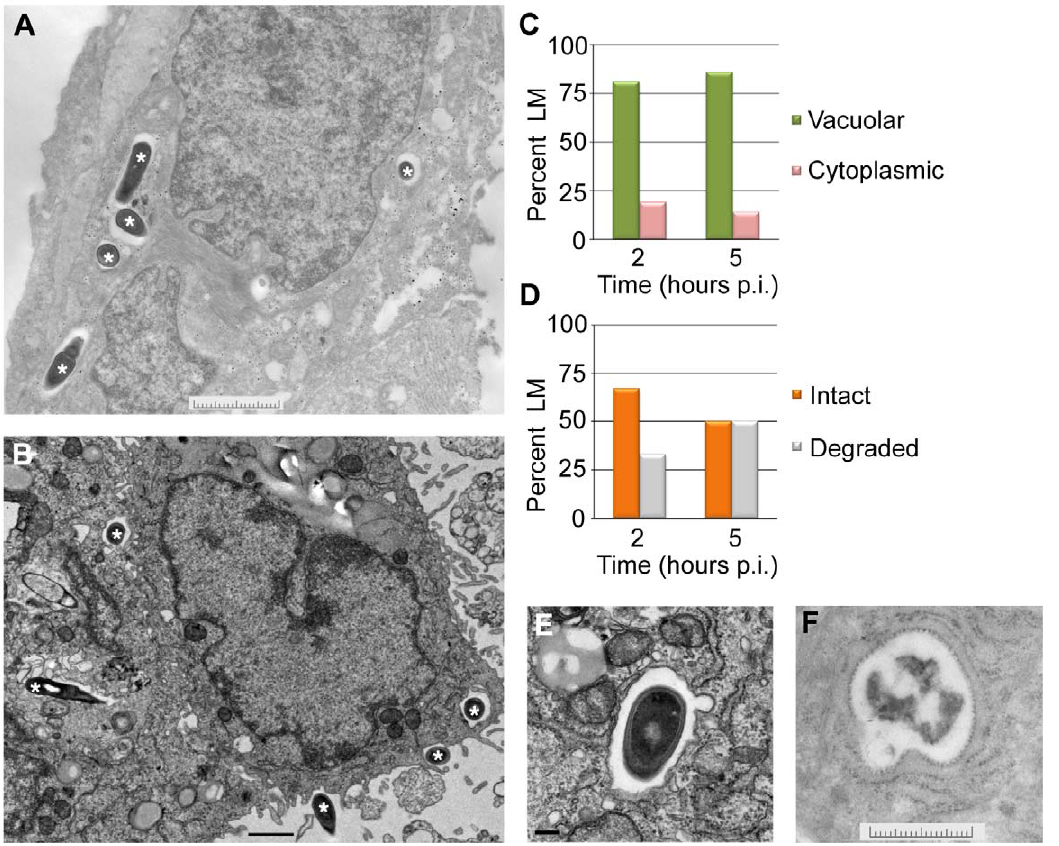
Figure 5. L.monocytogenes (LM) in EVT is largely confined to vacuoles. ( A,B ) Representative transmission electron micrographs from 2 ( A ) and 5 ( B ) hours post-inoculation (p.i.). Bacteria are marked with asterisks. Scale bars are 2 and 1 m m respectively. ( C ) Quantification of subcellular localization of bacteria in EVT at 2 and 5 hours p.i. ( D ) Quantification of intact versus degraded bacteria in vacuoles in EVT at 2 and 5 hours p.i. ( E ) Close-up image at 5 hours p.i. shows a single membrane vacuole surrounding intact bacterium. Scale bar is 100 nm. ( F ) Close-up image of degraded bacterium in a vacuole in EVT at 5 hours p.i. Scale bar is 2 m m.